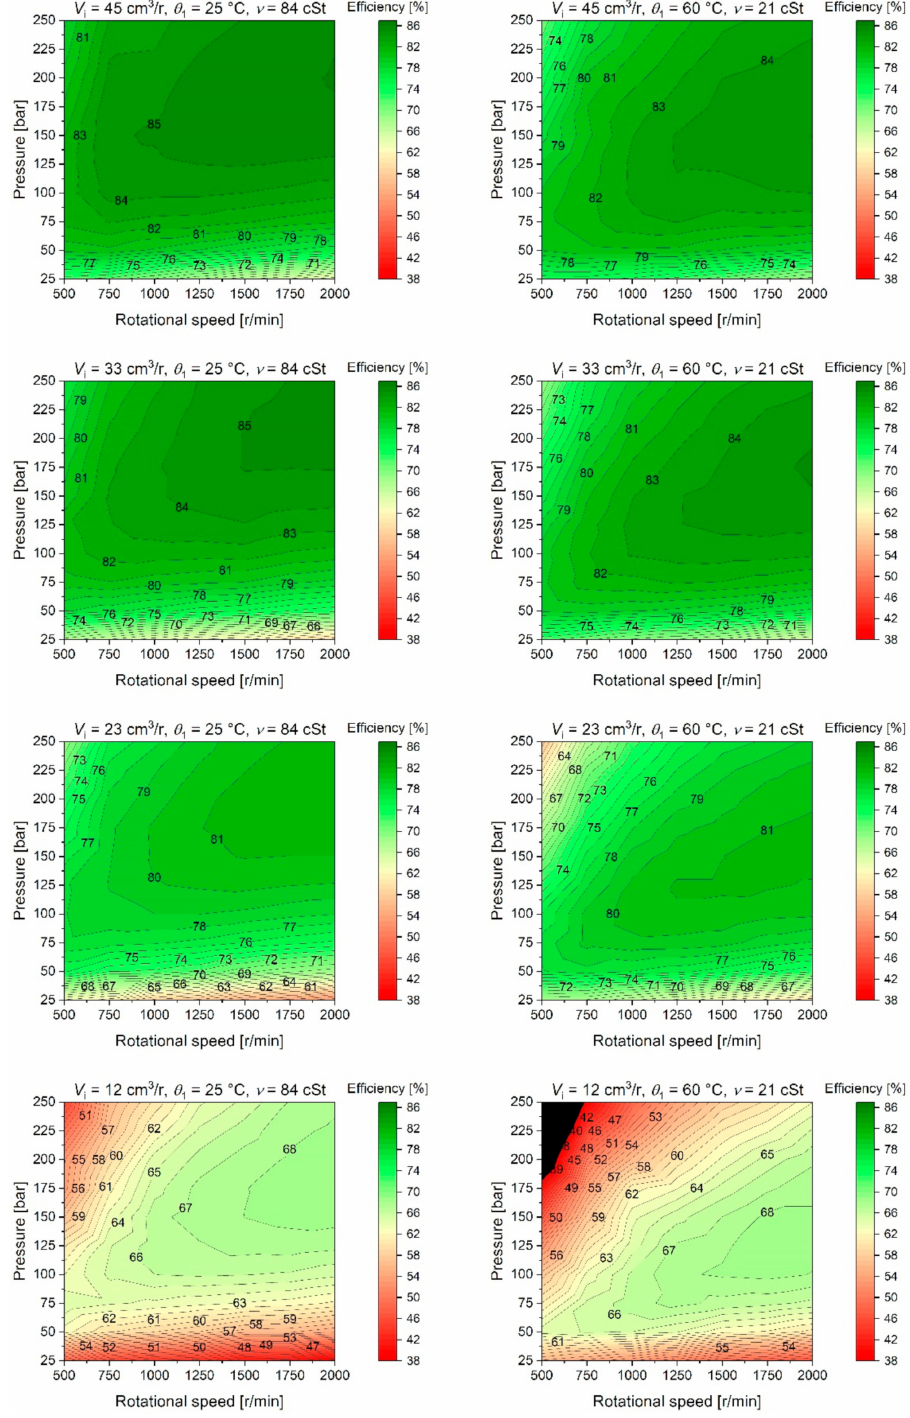
Figure 6. Total efficiency of an axial piston pump as a function of pressure and rotational speed with four values of derived capacities and two inlet temperatures. Contour lines were created from surface plots using the mesh determined by the step values presented in Table